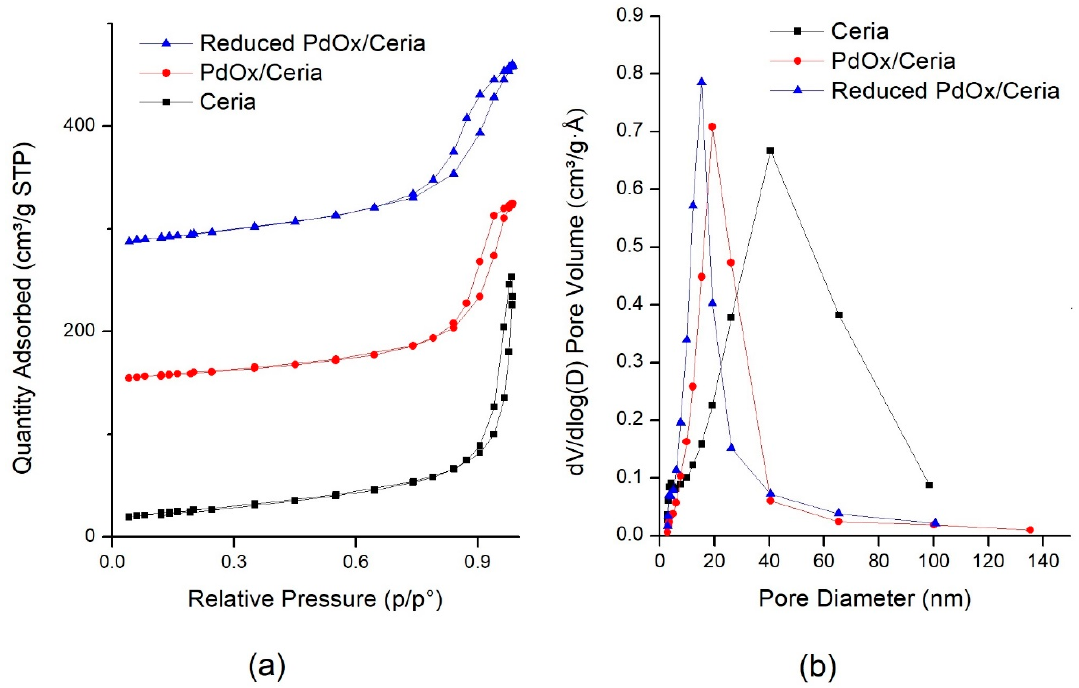
Figure 4. Brunauer–Emmet–Teller (BET) analysis of the catalysts: ( a ) Nitrogen adsorption and desorption isotherms as a function of p/p°; ( b ) pore-size distributions (PSD).